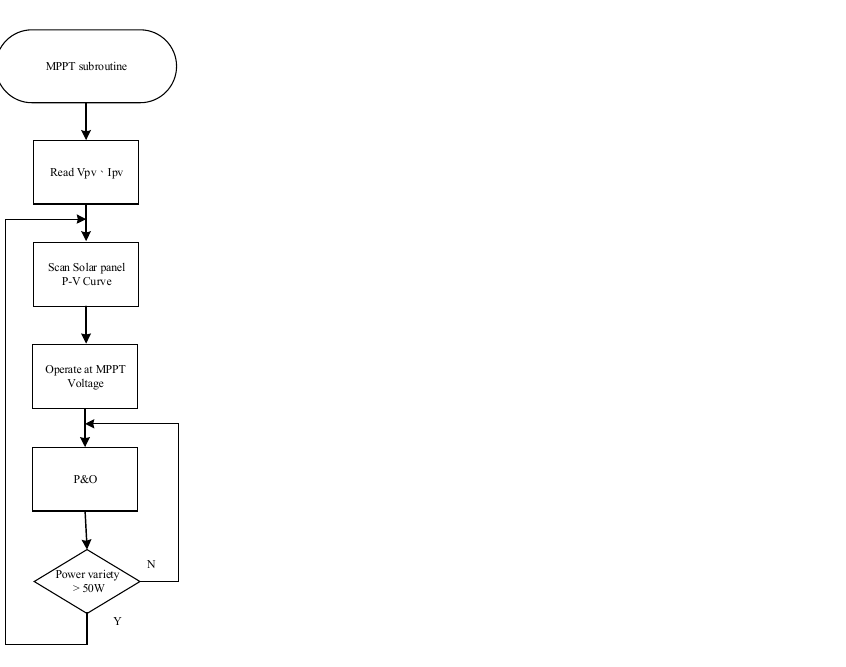
Figure 6. The P-V curve with the proposed GMPS method.